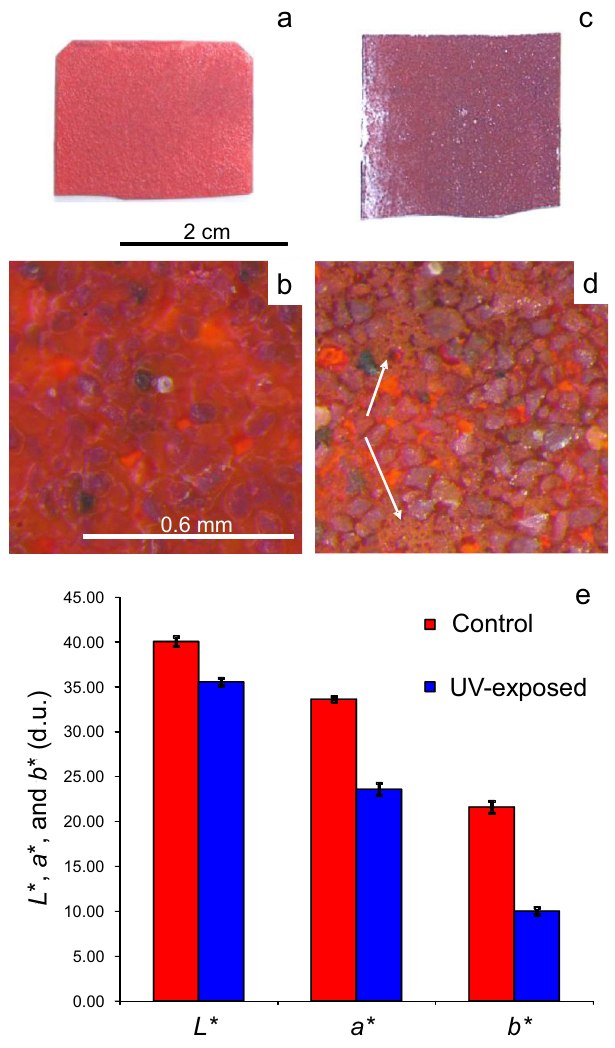
Fig. 5 Photographic and microscopic images of unaltered and UV- exposed paint mock-ups. a , b Unaltered control and c , d paint sample after 2 months of UV exposure (arrows indicate degraded binder, scale bars as in a , b , respectively); e colorimetric coordinates (error bars show standard deviation) of unaltered (control) and UV-aged paint